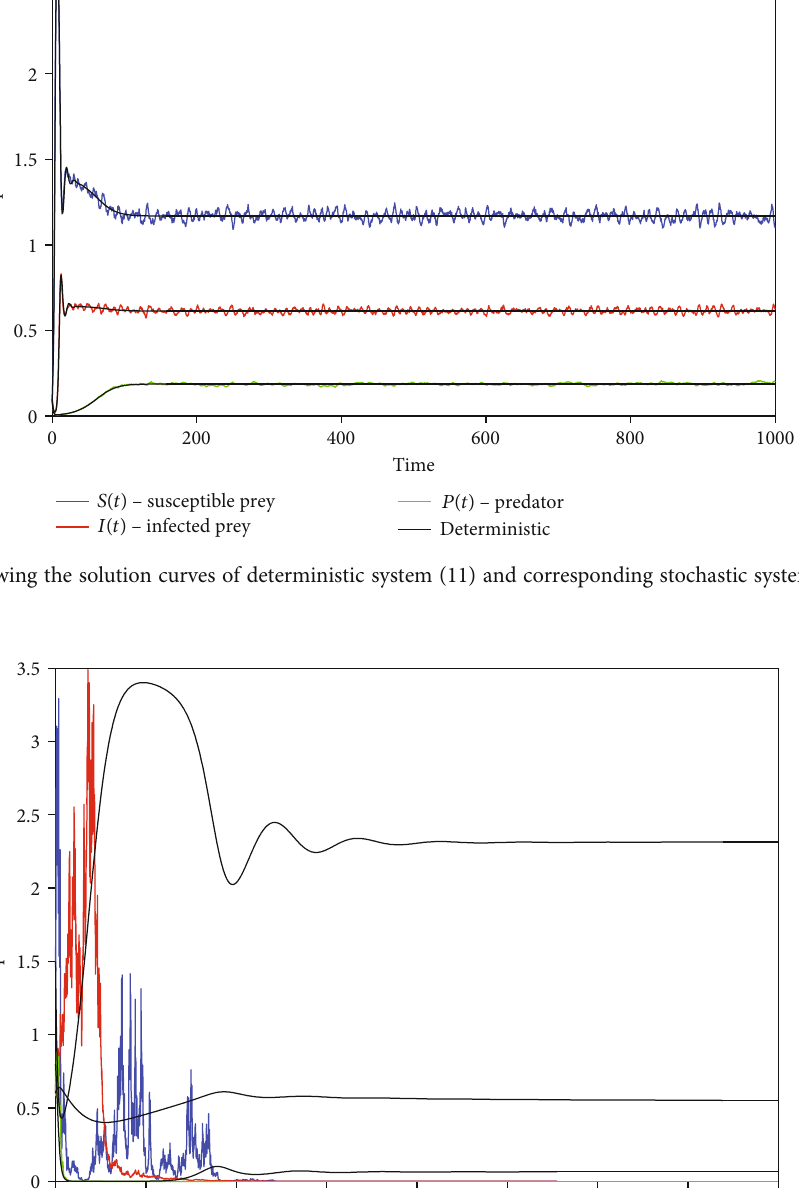
= 0 : 5, σ = 0 : 2, σ = 0 : 3 and the 1 2 3